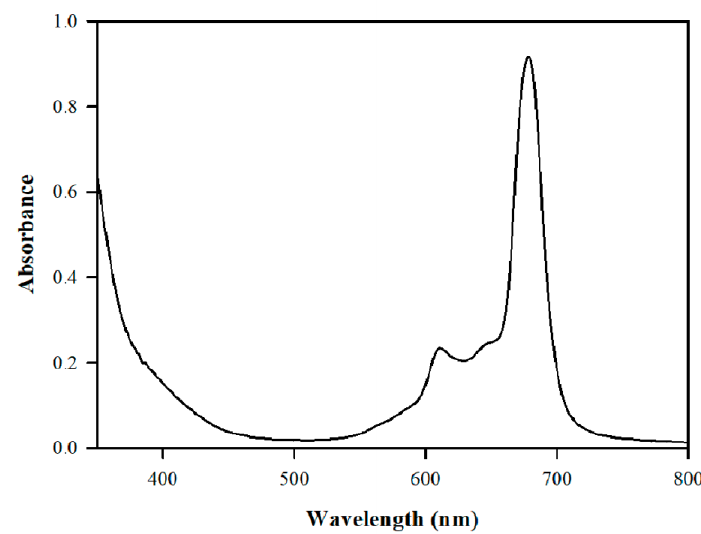
Figure 1. UV-vis spectrum of 1 × 10 − 5 M CuPc (4) in THF.